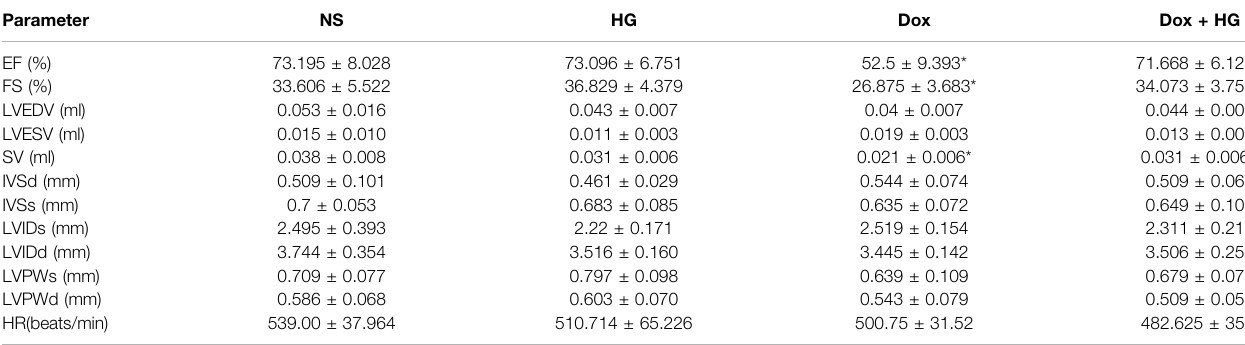
TABLE 1 | Echocardiographic indexes in each group of mice.